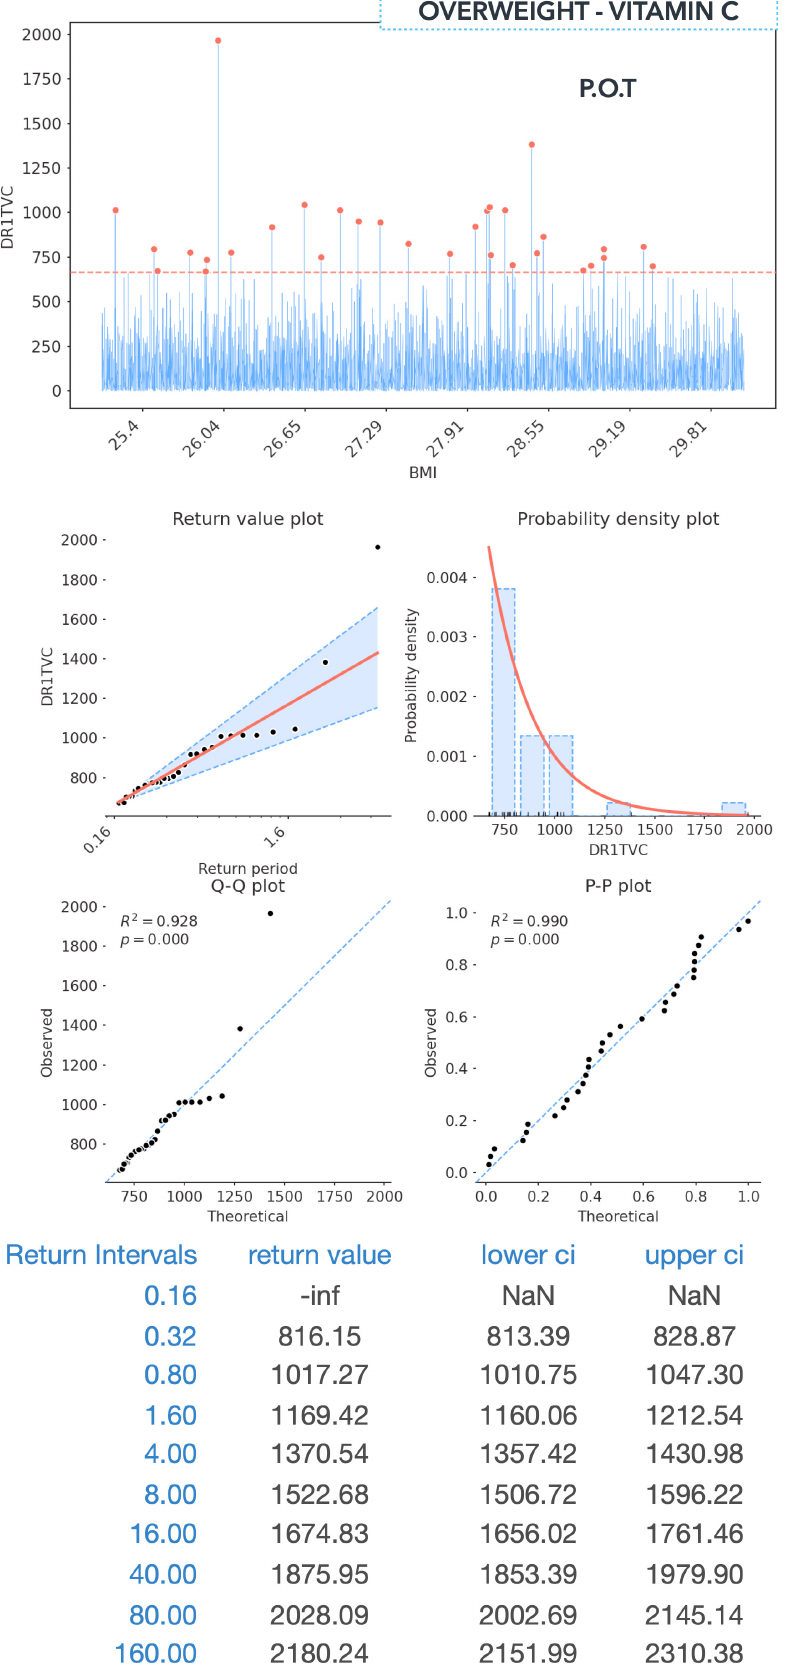
Figure 7. Overweight category–EVA of vitamin C